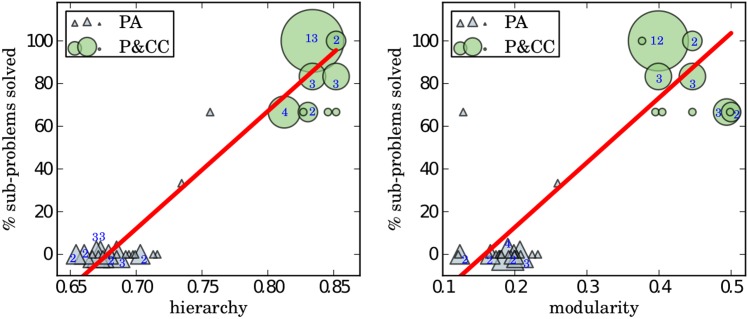
Solving sub-problems is correlated with both hierarchy (left) and modularity (right).The shape sizes and enclosed numbers indicate the number of networks at that coordinate (an empty shape indicates only one network is present). The Pearson’s correlation coefficient is 0.96 for hierarchy and 0.87 for modularity, indicating strong, linear, positive relationships. Both correlations are significant (p < 0.00001) according to a t-test with a correlation of zero as the null hypothesis.